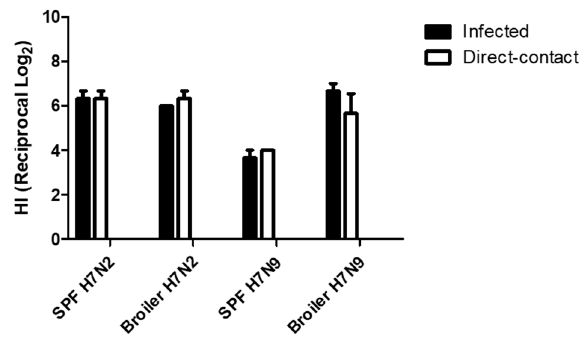
Figure 6. Seroconversion of SPF and broiler chickens. Serum samples were collected from Infected and contact exposure birds at 14 days post-exposure. Seroconversion was determined by HI assay.